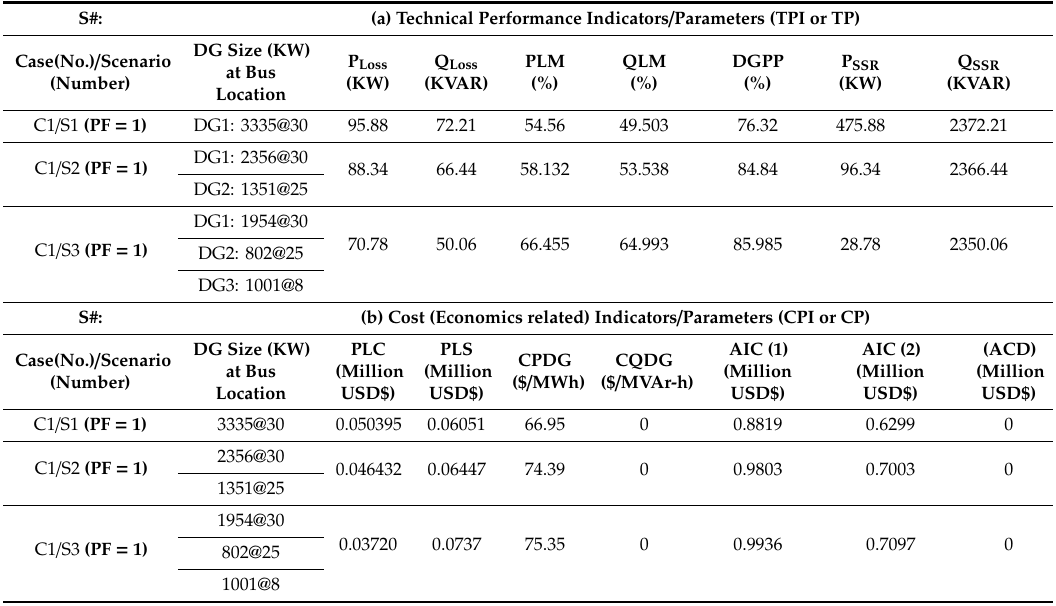
Table 5. (a) Overview of technical performance evaluation analysis in Case 1 for 33-bus TDS. (b) Overview of Cost-Economics performance evaluation analysis in Case 1 for 33-bus